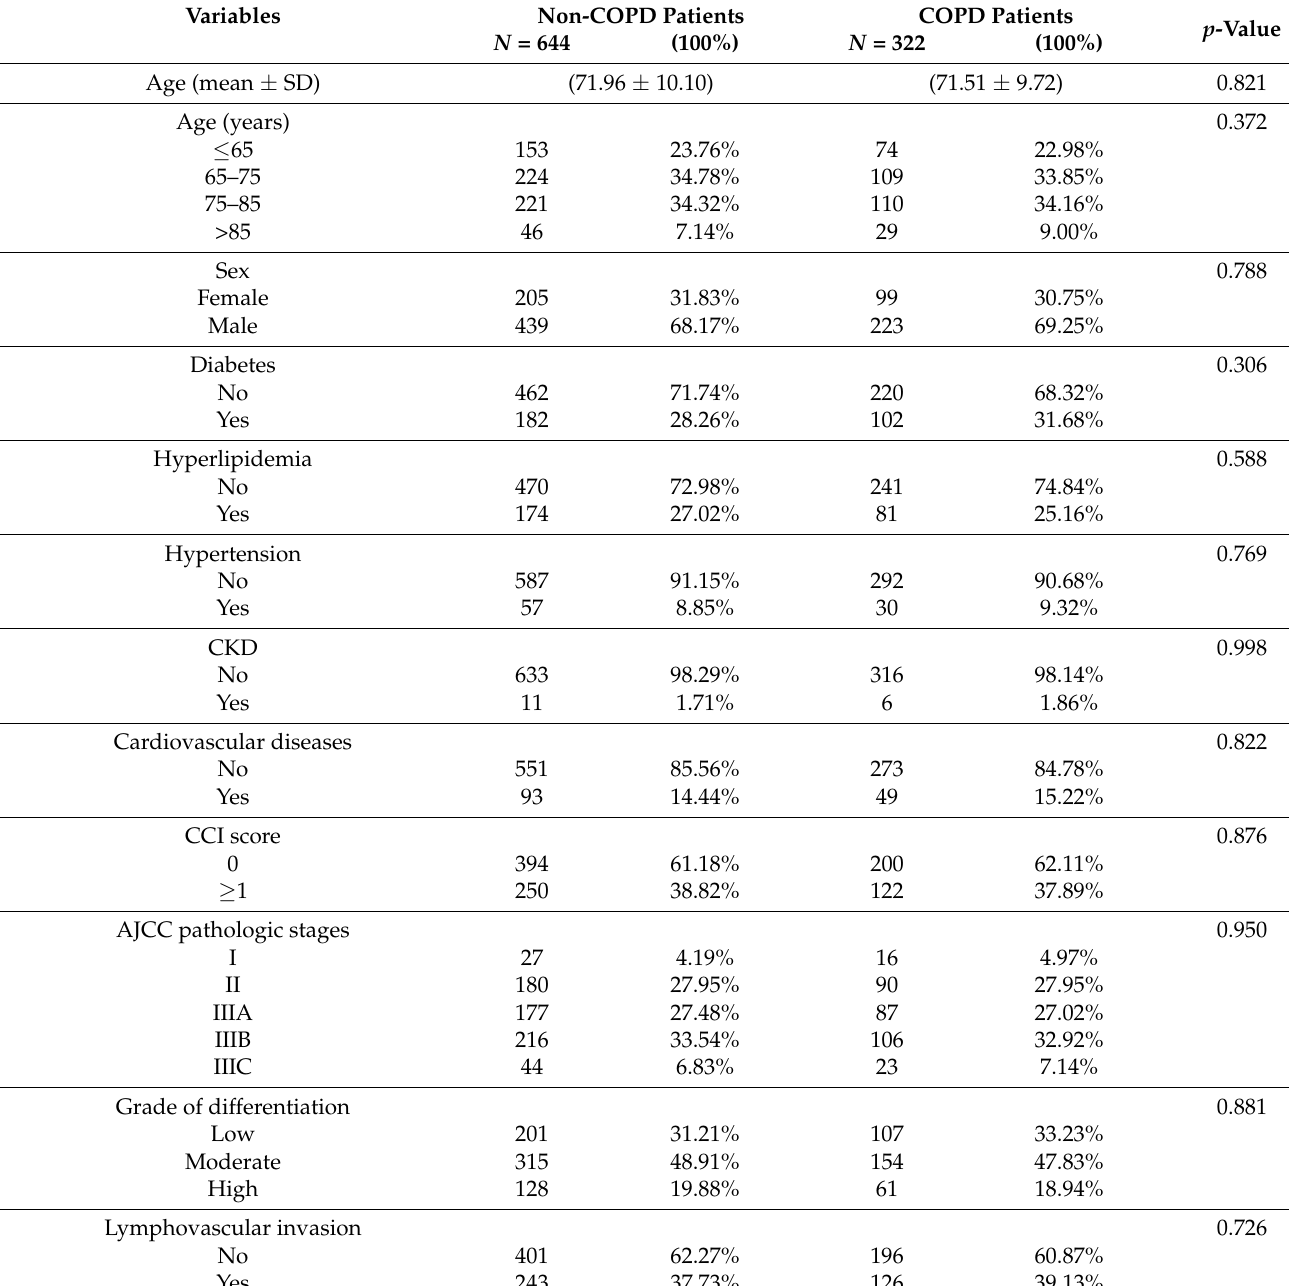
Table 1. Characteristics of patients with rectal adenocarcinoma with or without smoking-related chronic obstructive pulmonary disease before surgery after propensity score